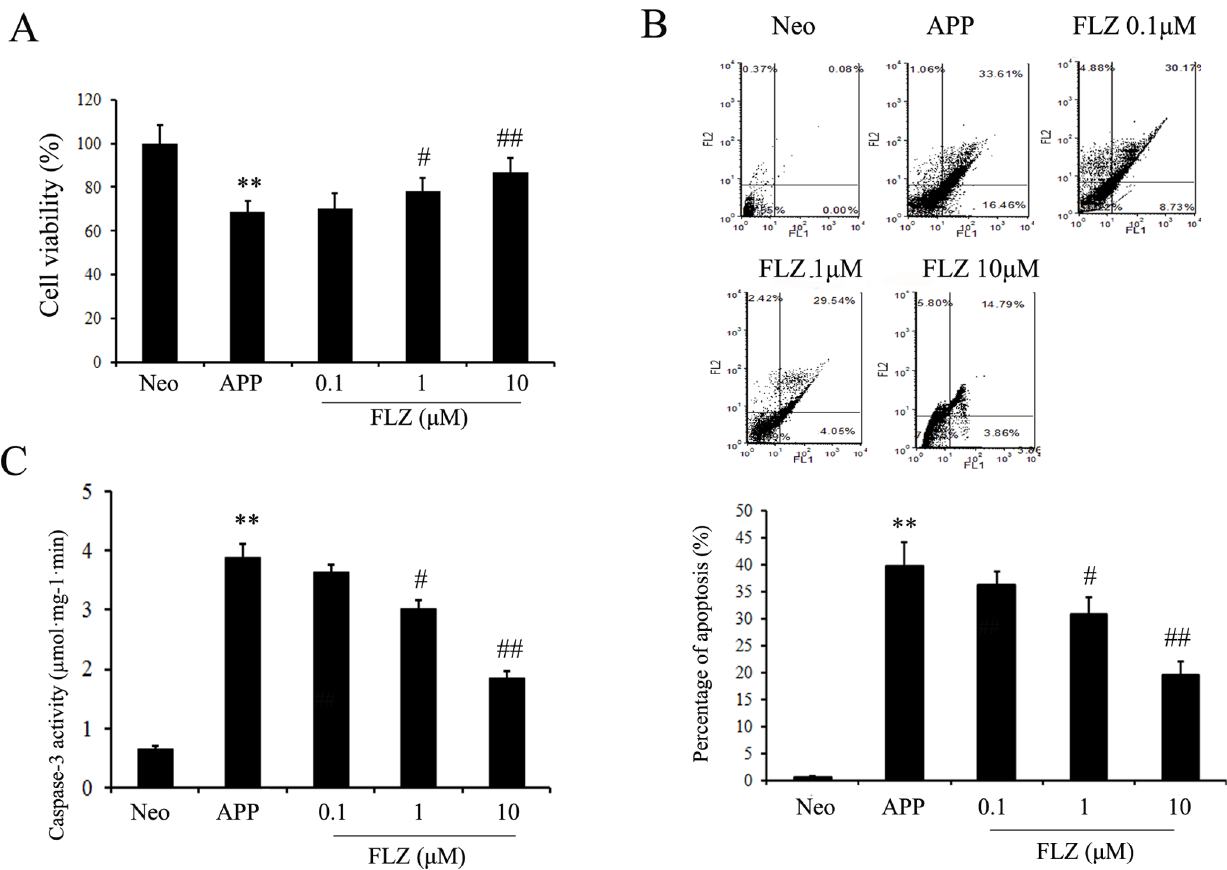
Figure 3. FLZ protected SH-SY5Y (APPwt/swe) cells from apoptosis. SH-SY5Y (APPwt/swe) cells were grown in ‘‘stimulating medium’’ containing 50% DMEM, 50% Opti-MEM, 0.5% FBS, 200 m g/ml G418 and 10 mM butyric acid sodium salt for 12 h to induce the transgene expression. FLZ (0.1, 1 and 10 m M) were incubated with cells for 24 h. (A) Cell viability of SH-SY5Y (APPwt/swe) cells. (B) Apoptosis of SH-SY5Y (APPwt/swe) cells measured by flow cytometry with Annexin-V/PI staining. Bar chart is the statistical of the sum of early and late cell apoptosis. (C) Caspase-3 activity of SH-SY5Y (APPwt/swe) cells. Results were expressed as mean 6 SD from 6 independent experiments. ** P , 0.01 vs . Neo SH-SY5Y cells, # P , 0.05, ## P , 0.01 vs . solvent-treated SH-SY5Y (APPwt/swe)